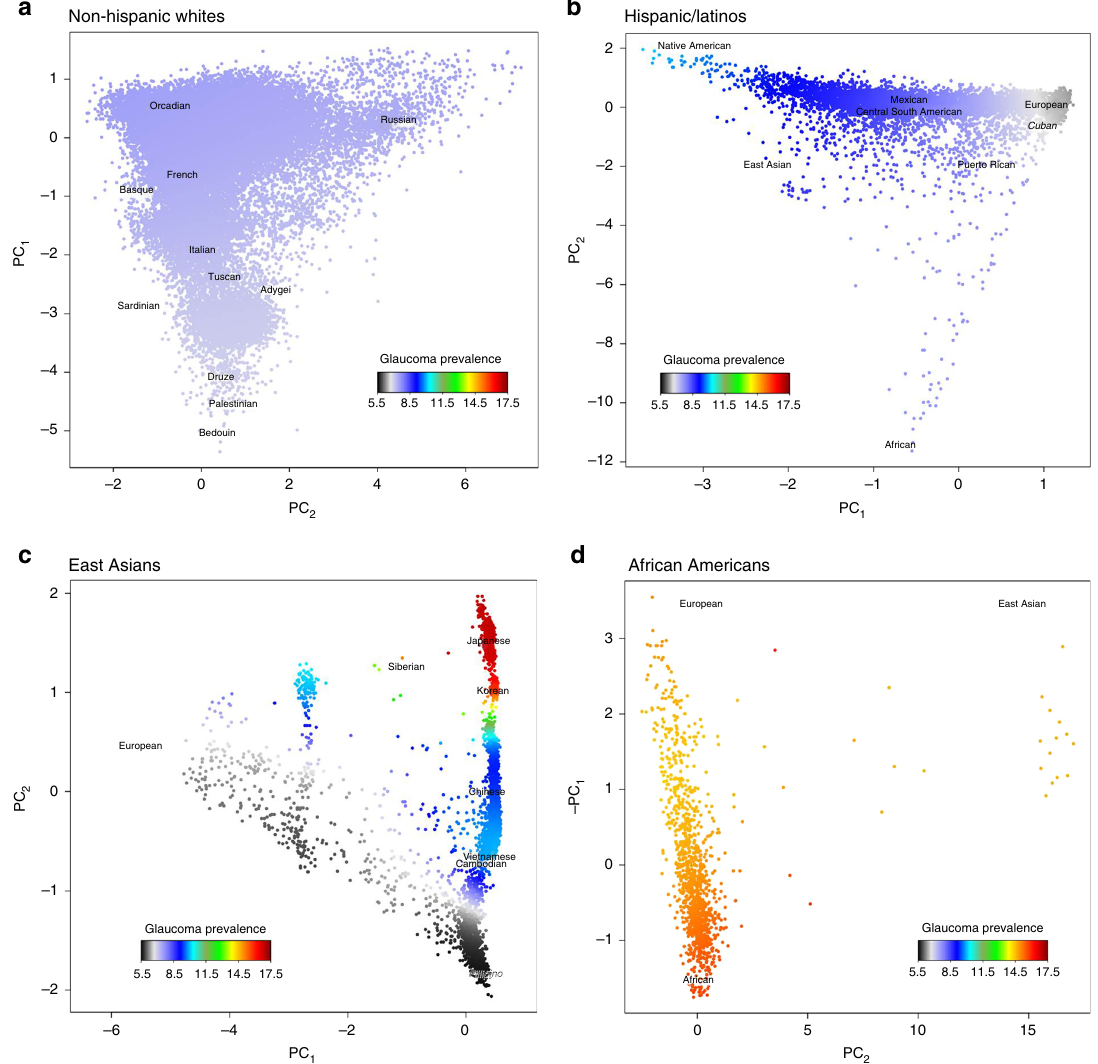
Fig. 1 Plots of POAG prevalence versus genetic ancestry in GERA. POAG prevalence is indicated on a color scale, standardized across groups, with warmer colors indicating higher prevalence. Axes re fl ect the fi rst two principal components of ancestry in each group. The phenotype distribution was smoothed over the PCs (within the individuals in each respective fi gure), which were divided by their standard deviation for interpretability (see Methods). Human Genome Diversity Project populations are plotted at their relative positions in each fi gure. Human Genome Diversity Project populations are presented in a plain font, and GERA populations are presented in italics font. a Non-Hispanic whites, b Hispanic/Latinos, c East Asians, and d